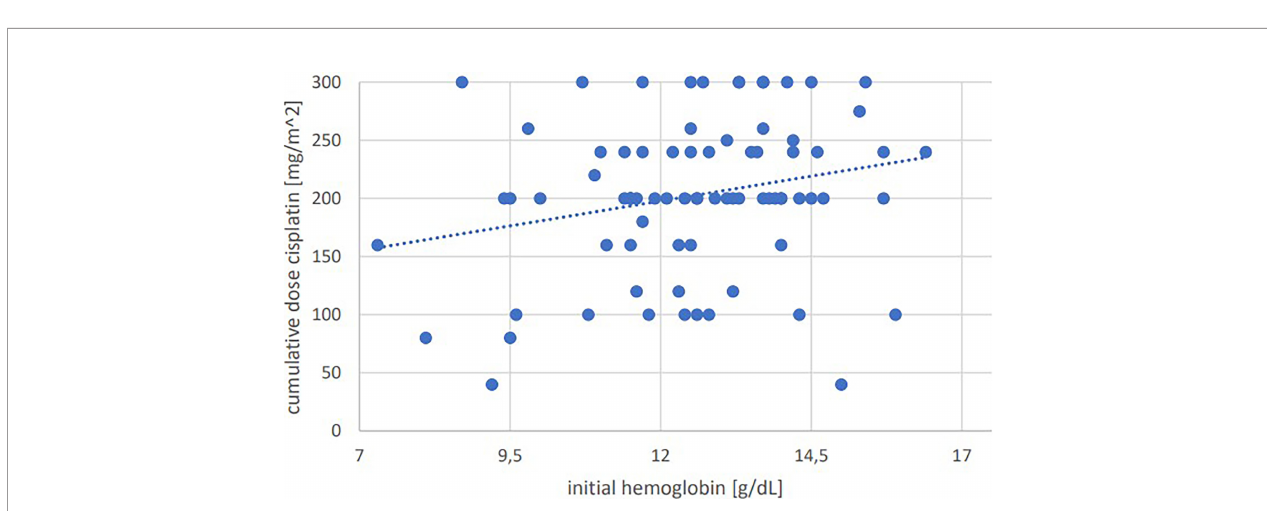
FIGURE 1 | Bivariate correlation analysis of initial GFR values [ml/min/1,73m^2] with fi nal cumulative total dose of cisplatin achieved [mg/m^2]: p=0.001, Pearson ’ s r=0.364; individual values as points, dashed linear trend line.